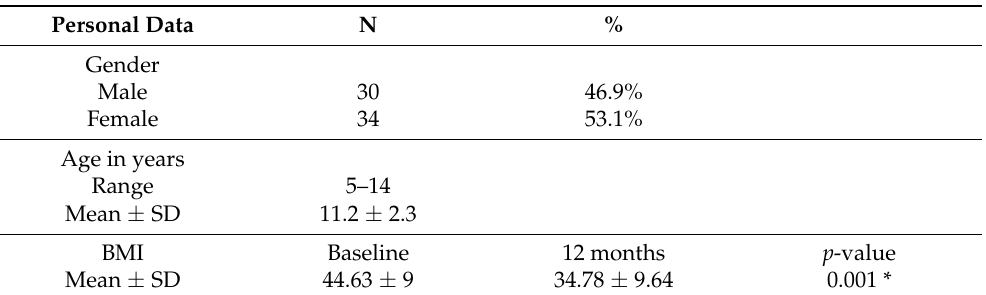
Table 1. Personal data of investigated study participants—a total cohort of 64 children with type 2 diabetes mellitus that underwent LSG surgery were included. Patients’ ages ranged from 5 to 14 years, with a mean age of 11.2 ± 2.3 years old. BMI was 44.63 ± 9 pre-operative and 35 ± 10 post-operative ( p = 0.001). Overall, 34 (53.1%) children were females and 30 (46.9%) were males.